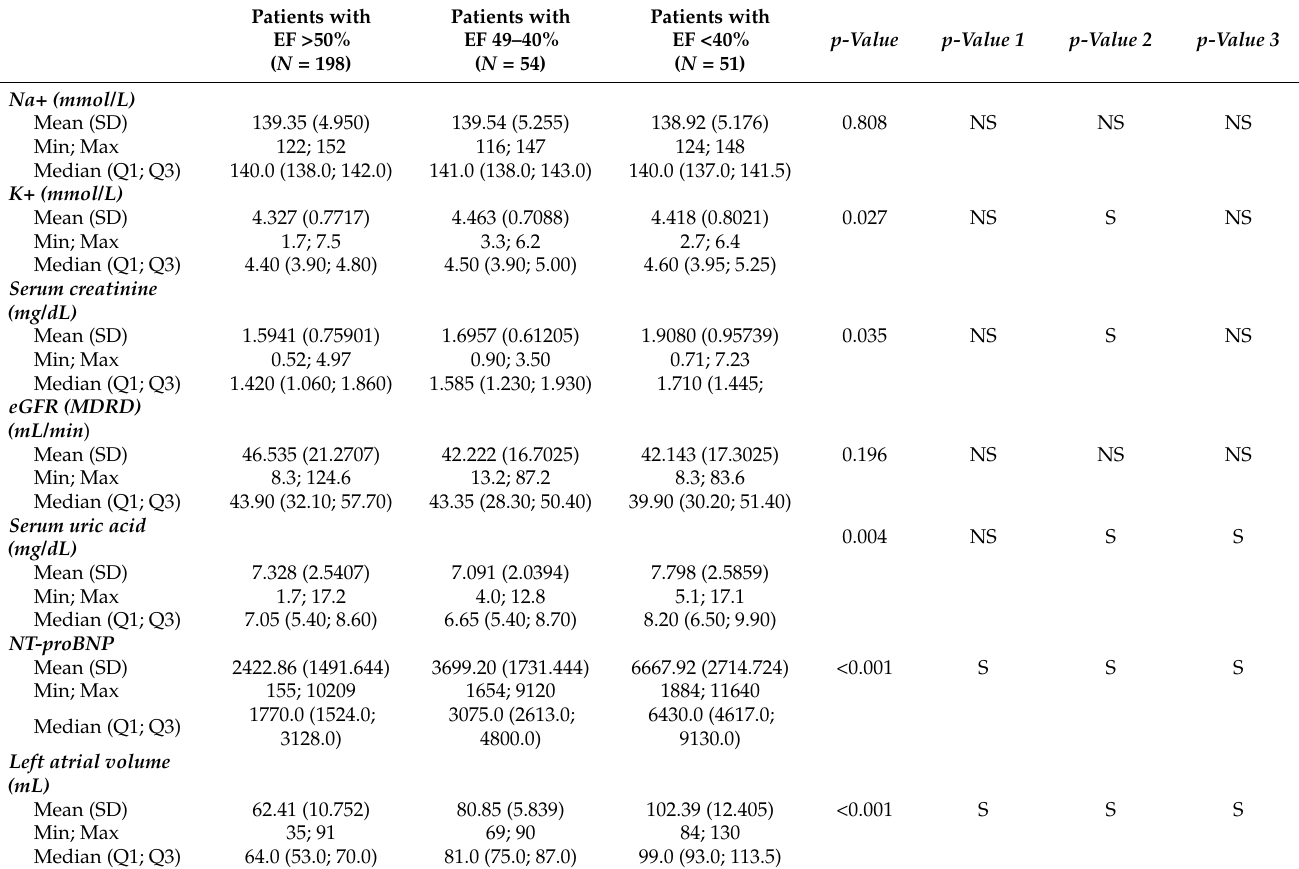
Table 3. Summary of main laboratory test results by FEVS (note FEVS = left ventricular ejection fraction) categories. Patients with EF